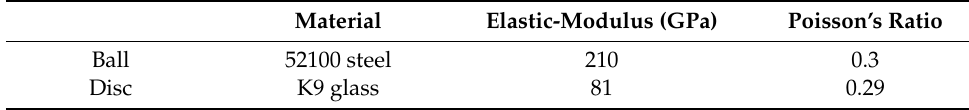
Table 1. Sample parameters.